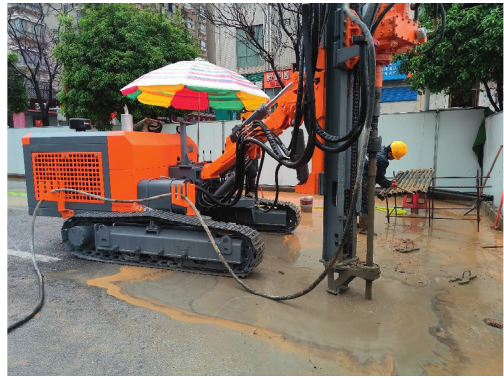
Figure 7: Karst cave